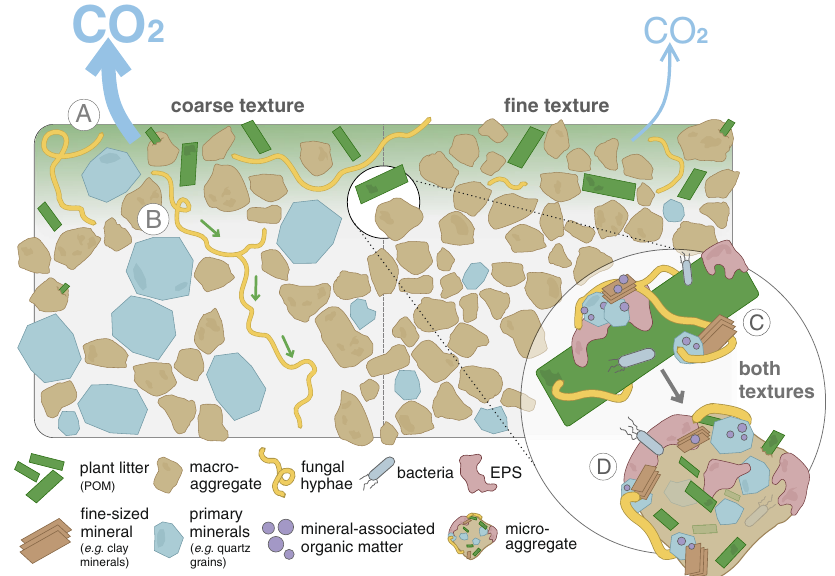
Fig. 8 Aggregate and mineral-associated organic matter formation in soils of different textures driven by interactions between litter, microorganisms, and soil matrix. Fresh litter surfaces serve as hotspots of microbial activity driving the formation of organo-mineral associations in concert with comprising a nucleus for aggregate formation. A Coarse soil texture fosters higher mineralization of native and litter-derived organic matter resulting in higher CO 2 emissions compared to the fi ne-textured soil. B Fungal hyphae in coarse-textured soils promote the translocation of litter-derived C away from the litter source. C Regardless of texture, gluing of fi ne-sized minerals, driven by microbial products (EPS) on the fresh litter surface leads to ( D ) the formation of soil aggregates directly at the plant-soil